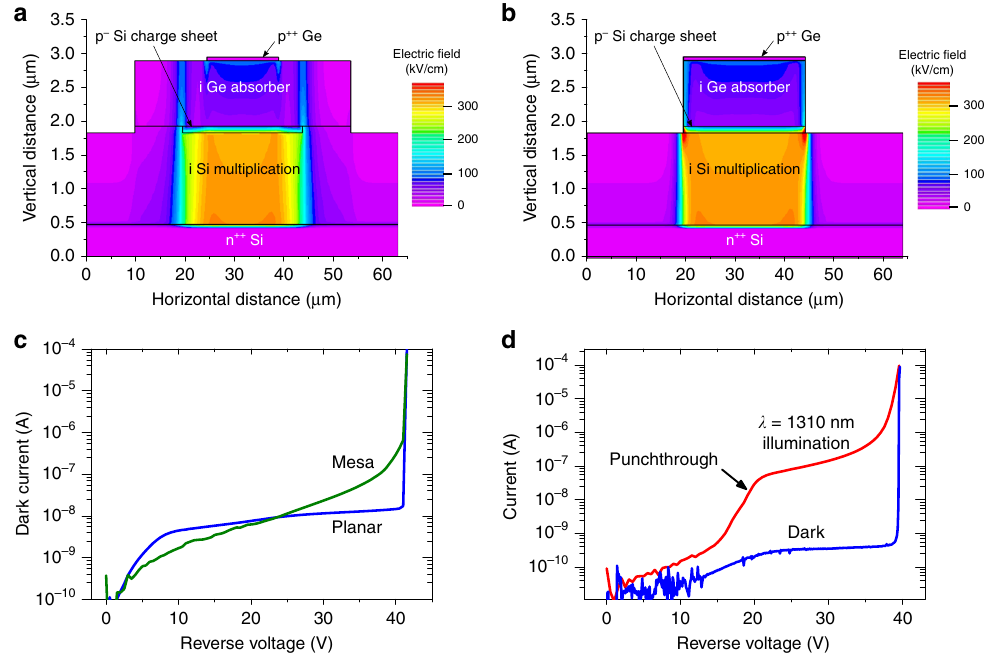
Fig. 2 Single-photon avalanche diode modelling and current-voltage behaviour. a Electric fi eld pro fi le at 5% excess bias for the planar single-photon avalanche diode (SPAD). b Electric fi eld pro fi le at 5% excess bias for the mesa etched SPAD. c Current-voltage measurements on 100 µ m diameter planar (blue line) and mesa etched (green line) structures at a temperature of 100 K under dark conditions. d Current-voltage measurements on a 100 µ m diameter planar device at a temperature of 78 K. The graph shows dark current (blue line) and photocurrent when illuminated with a 1310 nm laser (red line). Punchthrough is evident at 20